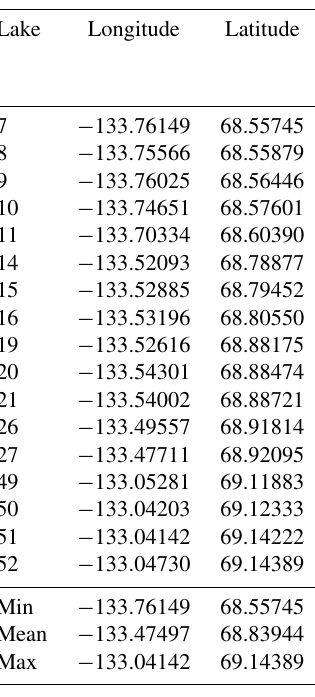
Table 1. Lake and watershed properties for sampled lakes. Lake locations are shown in Fig.